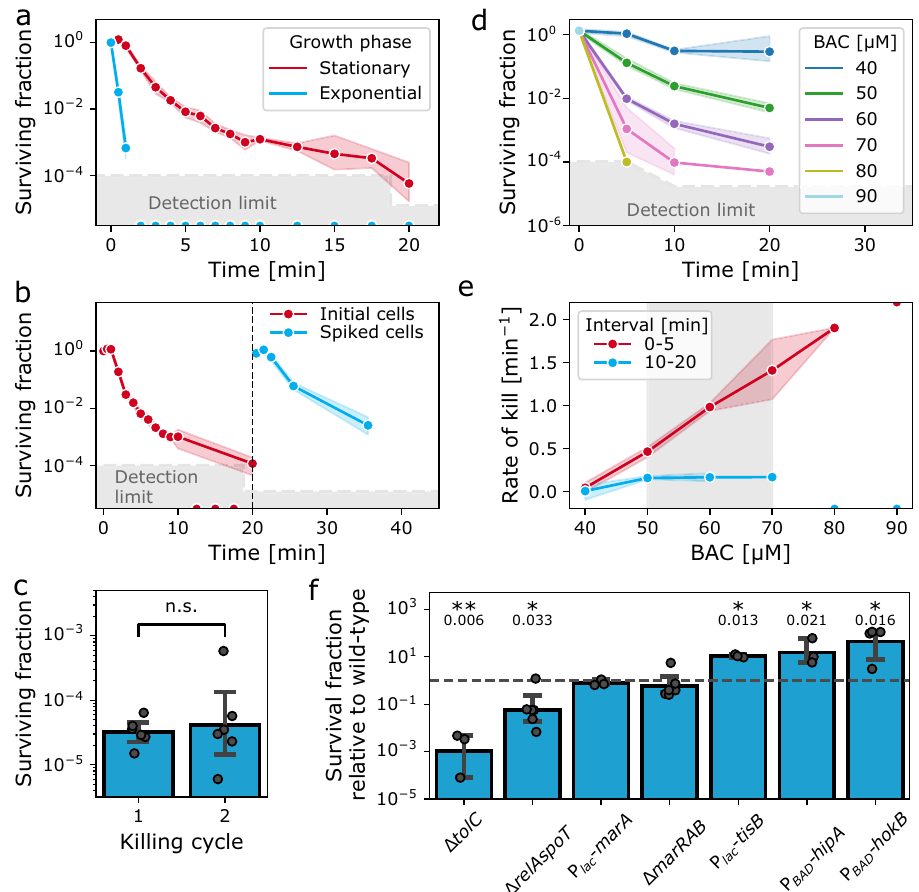
Fig. 1 E. coli forms persisters against benzalkonium chloride. a Time kill kinetics of exponentially growing and stationary phase E. coli cultures exposed to BAC at 3× MIC (i.e., 60 µ M or 21 µ g/ml). Points: geometric mean ± 95% C.I. ( n = 6 biological replicates). Detection limit: 166 cfu/ml. Half circles on the x - axis indicate replicates with a surviving fraction below the detection limit. b Bimodal killing kinetics are due to a tolerant subpopulation, not due